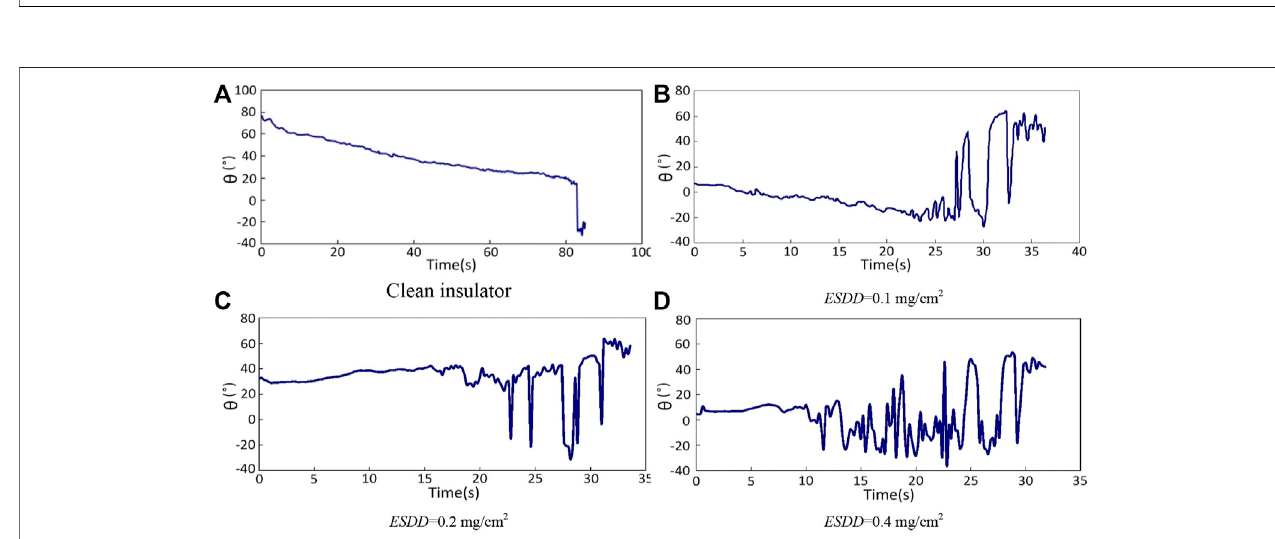
FIGURE 7 | Curves of θ of LC under different ESDD .